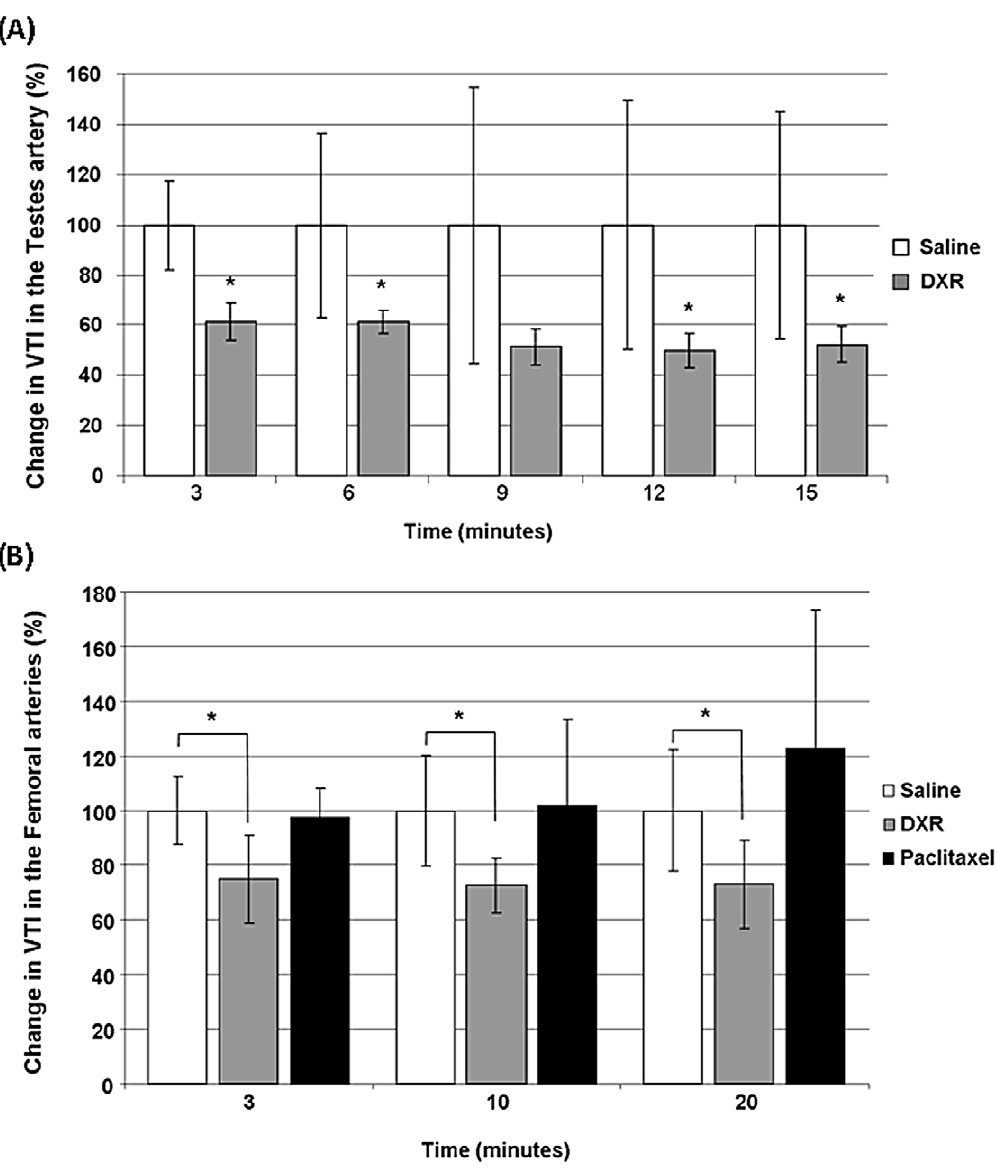
Figure 2. Pulse-wave Doppler measurement of testicular and femoral arterial blood flow. Using PW Doppler mode, blood flow was measured and quantified by analyzing Velocity-Time Integral (VTI) using the appropriate VisualSonics software. PW Doppler blood flow was continuously monitored before and following doxorubicin administration. Saline-injected mice were standardized to 100% as a reference to chemotherapy-injected mice. Results are presented as mean 6 SD . The data obtained from the images as presented in figure 1A, was presented as an Excell curve provided by the VisualSonics software. A. Graphic representation of testicular blood flow 3, 6, 9, 12 and 15 minutes after doxorubicin (n=8) or saline (n=7) injection indicating a rapid and constant fall in testicular blood flow of doxorubicin treated mice (* P , 0.01). B. Graphic representation of femoral blood flow volume 3, 10 and 20 minutes after doxorubicin (n=12), Paclitaxel (n=14) or saline (n=10) injection indicating a rapid and constant fall in femoral blood flow of doxorubicin treated mice (* P ,